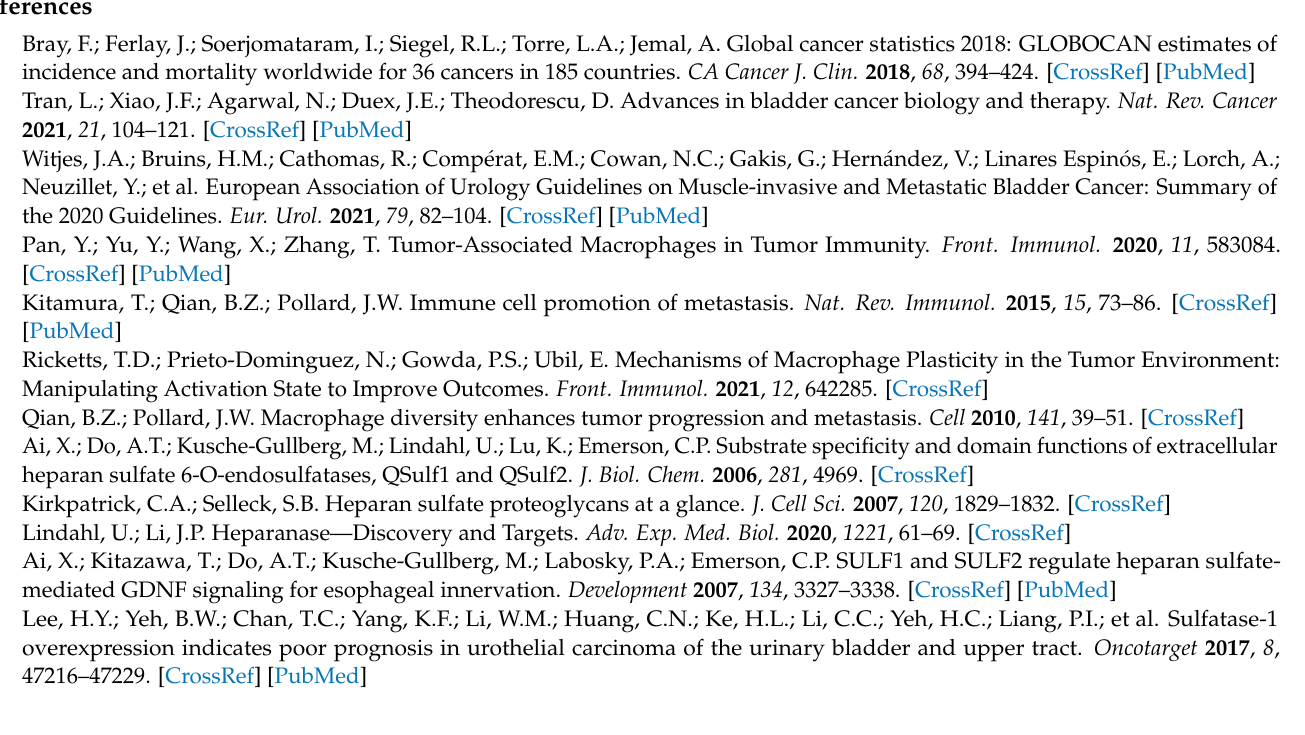
β -catenin expression. Table S1: Characteristics of bladder cancer patients in four cohorts. Table S2: List of antibodies. Table S3: SULF2 knockdown sequence and primer. File S1: Original